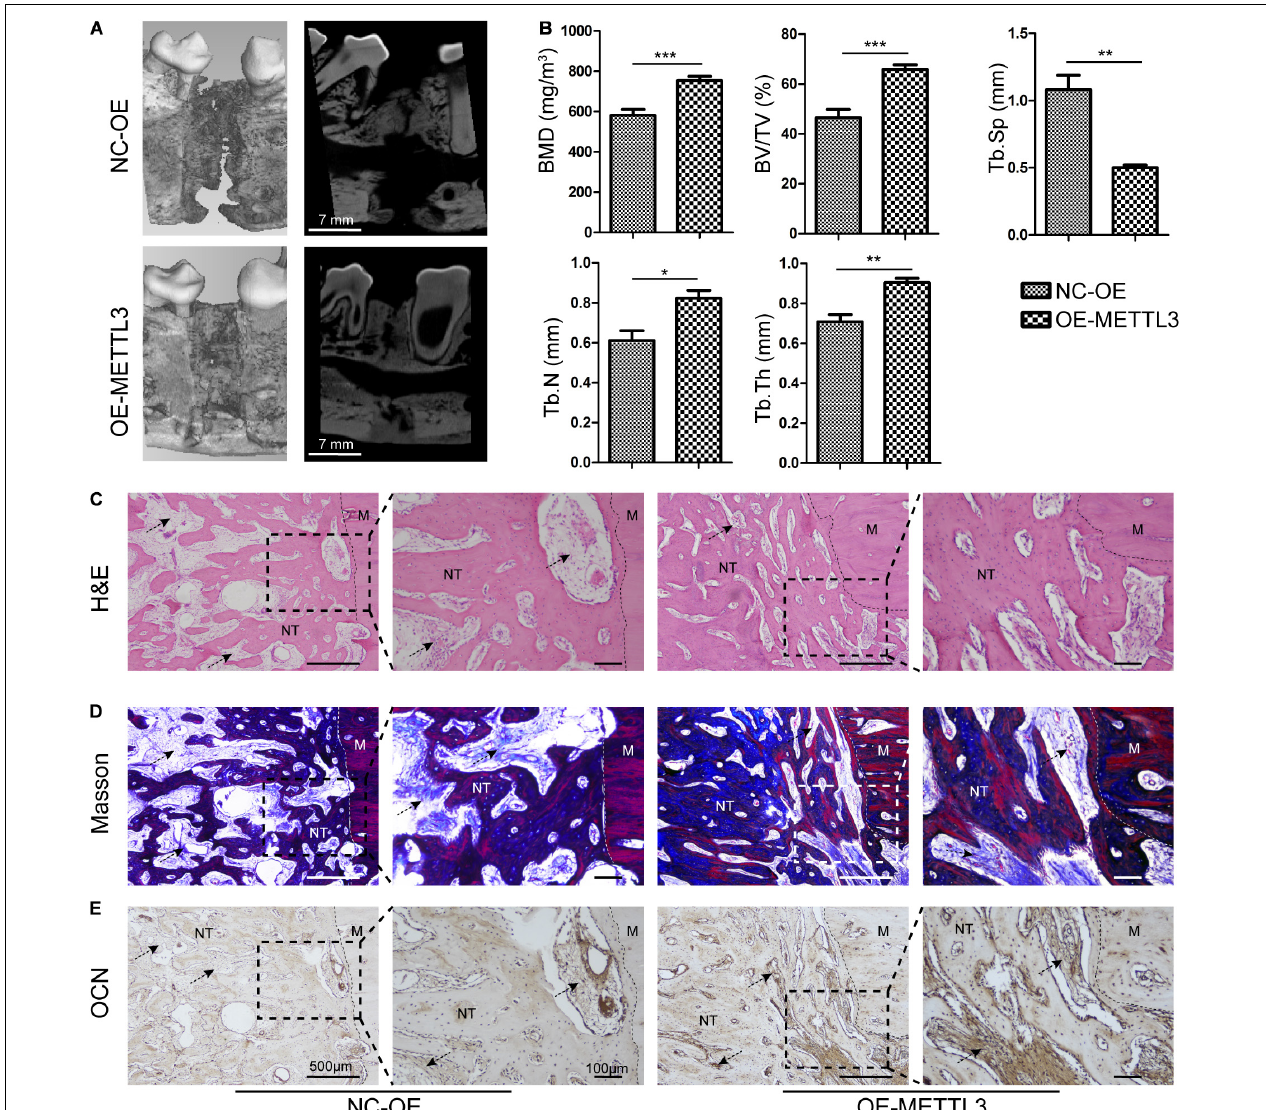
FIGURE 5 | Methyltransferase-like 3 regulates angiogenesis and DO regeneration responses. (A,B) Representative 3D and longitudinal images (A) and quantitative analysis (B) of micro-CT data, including bone mineral density (BMD), bone volume/tissue volume (BV/TV), trabecular separation (Tb. Sp), trabecular number (Tb. N), and trabecular thickness (Tb. Th) of the mandibular distraction area after 4 weeks of consolidation. (C,D) For histological analyses, H&E (C) and Masson’s trichrome (D) staining of the MDO callus were performed in the different groups. (E) IHC assessment of OCN in the NC-OE and OE-METTL3 groups. NC-OE and OE-METTL3 groups were compared via Student’s t -tests. Arrows, extracellular matrix. M, Mandible, NT, Newly formed trabecula. Scale bars: 100 and 500 µ m. * P < 0.05, ** P < 0.01, *** P < 0.001 vs. NC-OE; n = 3 canine in each